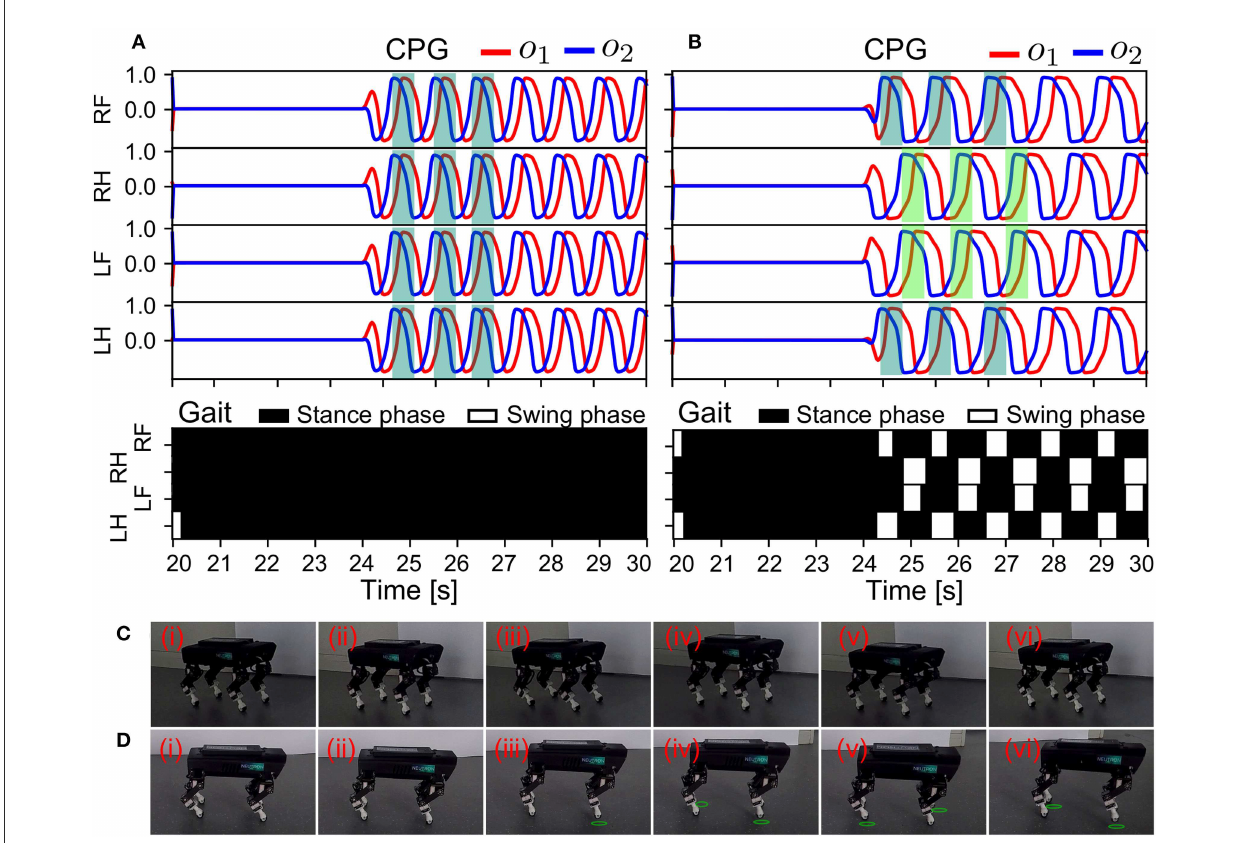
FIGURE12 Real-time data of the memorized locomotion and robot behavior in response to the resetting of the control in S3. The experiment was conducted using the control without and with the ANC. The results are shown in (A, B) , respectively. The different colors indicate phase shifts among the CPGs in (B) . (C, D) Snapshots of Lilibot under the adaptive neural control without and with the ANC, respectively. A green circle under a foot indicates that the foot was in the swing